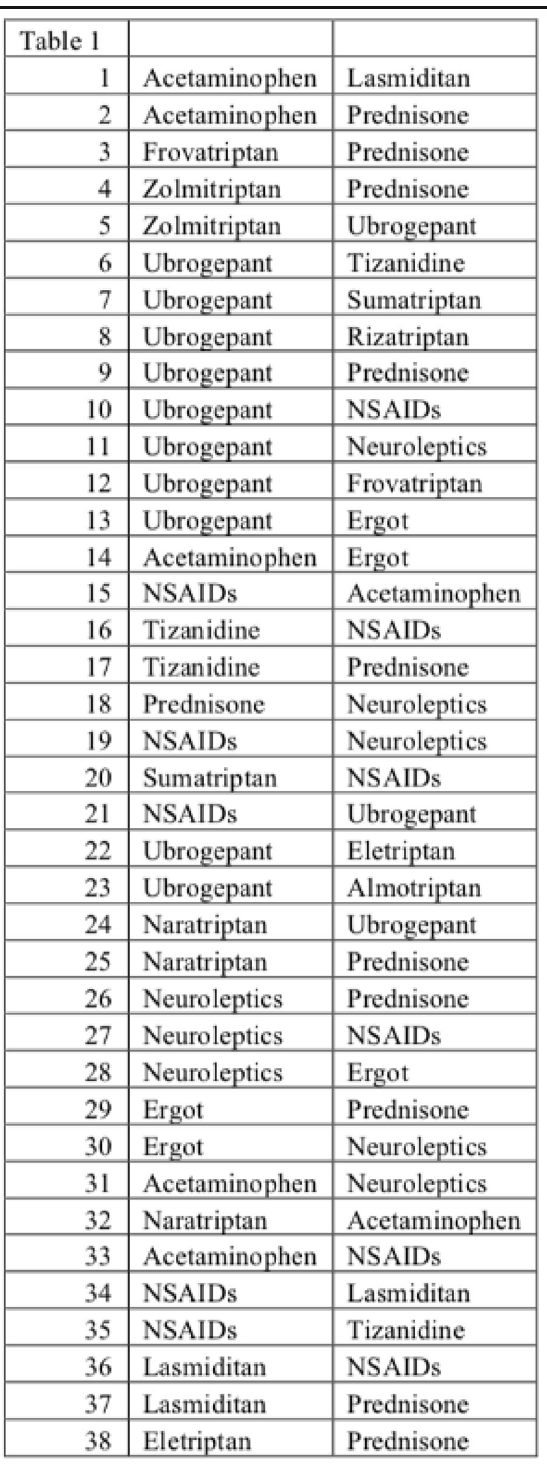
Table 1 (abstract P206). See text for